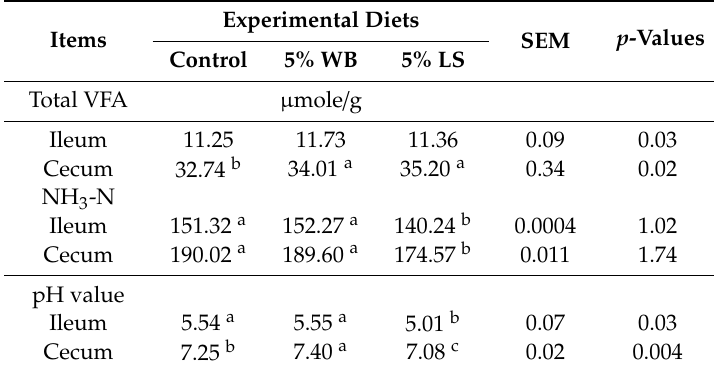
Table 3. E ff ects of LS supplementation on the total VFA concentrations, pH values, and NH 3 -N of the intestinal content of 35-day-old broilers 1 .